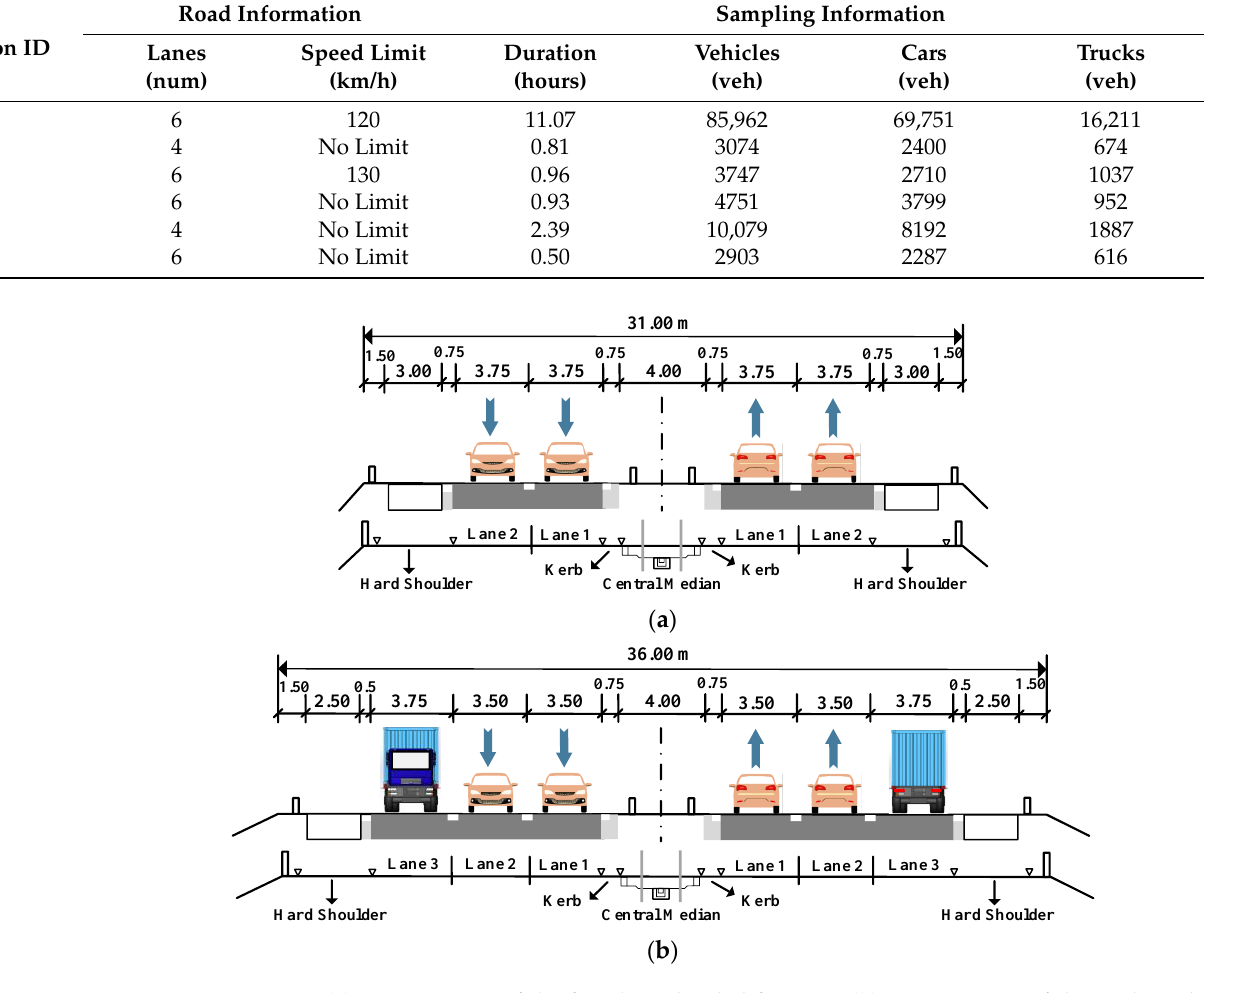
Figure 2. ( a ) Cross-section of the four-lane divided freeway; ( b ) Cross-section of the six-lane divided freeway.